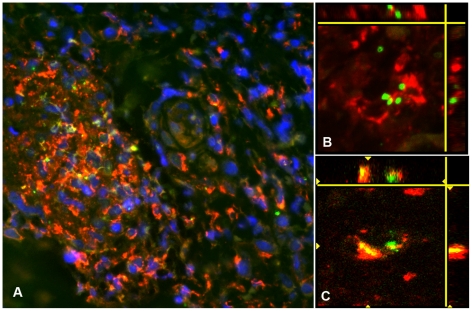

O. tsutsugamushi co-localize with CD68 positive macrophages in perivascular infiltrates.Panel A: Perivascular cuff formation and clusters of predominantly CD68+ macrophages, co-localizing closely with O. tsutsugamushi. Patient TM2193, magnification ×400. Magnification ×400, insert ×1000, double-immunolabeling: CD1a in red, O. tsutsugamushi in green and DAPI nuclear counterstain in blue. Panels B and C: Laser Scanning Micrographs with 3D stack projections of multiple 0.3 µm thin sections, depicting intact O. tsutsugamushi associated with CD68+ macrophages (panel B). Unambigous intracellular location of O. tsutsugamushi in a CD68+ cell (panel C). Patient TM2508, magnification ×1000, CD68 labeled in red, O. tsutsugamushi in green.